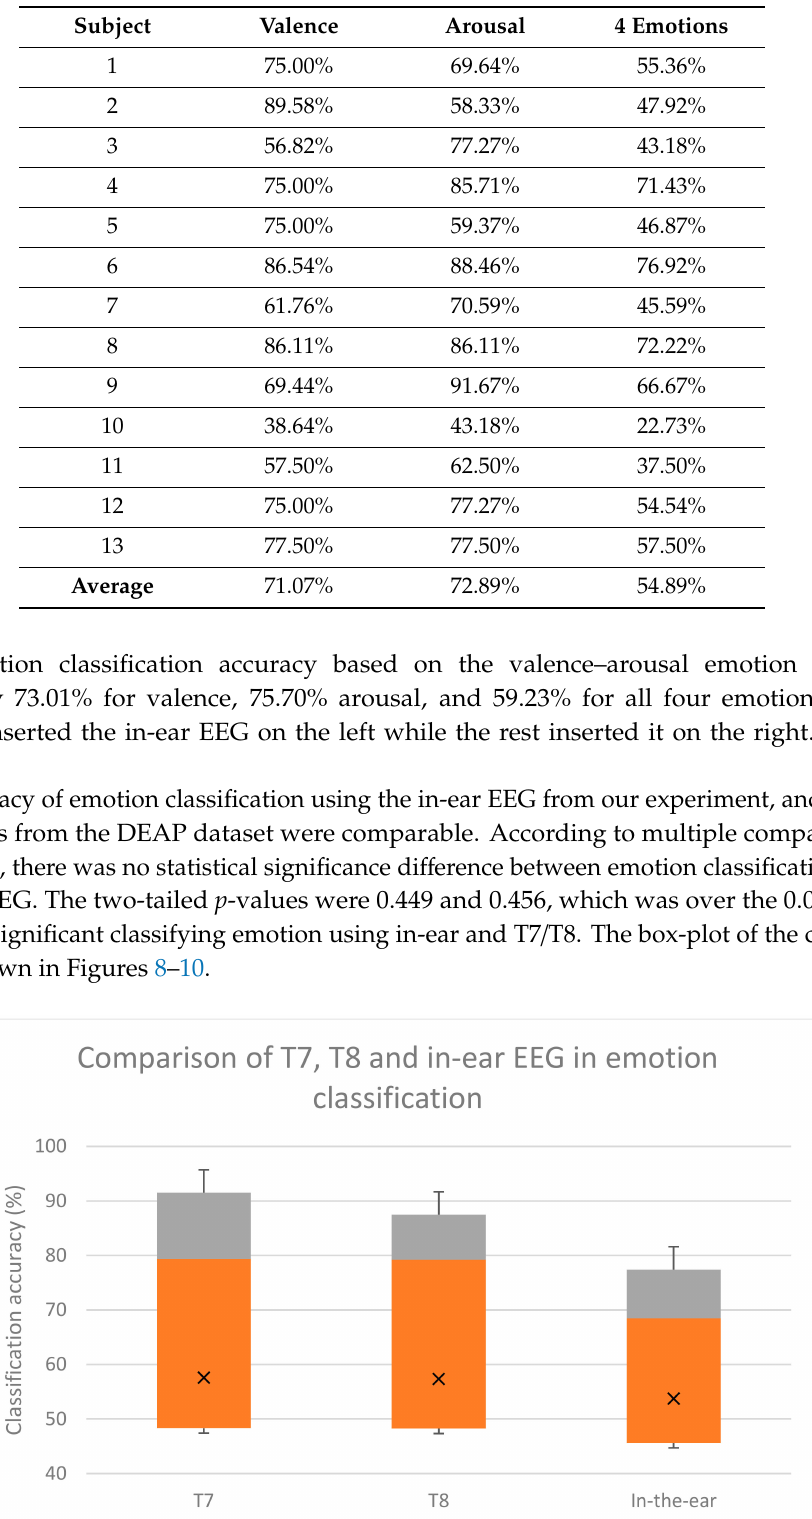
Table 1. Emotion classification result from each subject.